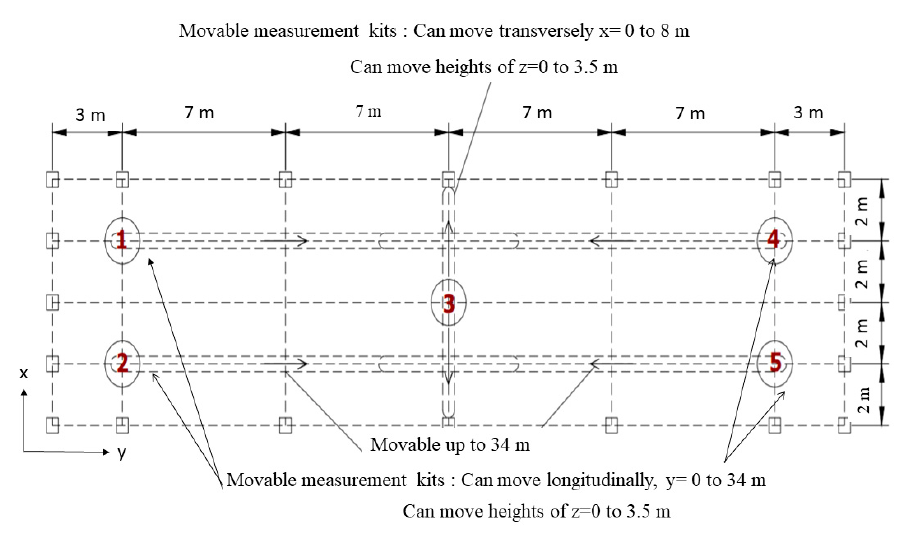
Figure 3. Plan view of instrumentation installed in the greenhouse. Labelled 1 through 5 are individual measurement kits each containing two anemometers, a temperature, a relative humidity sensor, and a small data logger. Kit 3 can move along the width while the other kits move along the length of the greenhouse. All of the kits can be moved up to a height of 3.5 m from the floor level using a movable vertical platform.